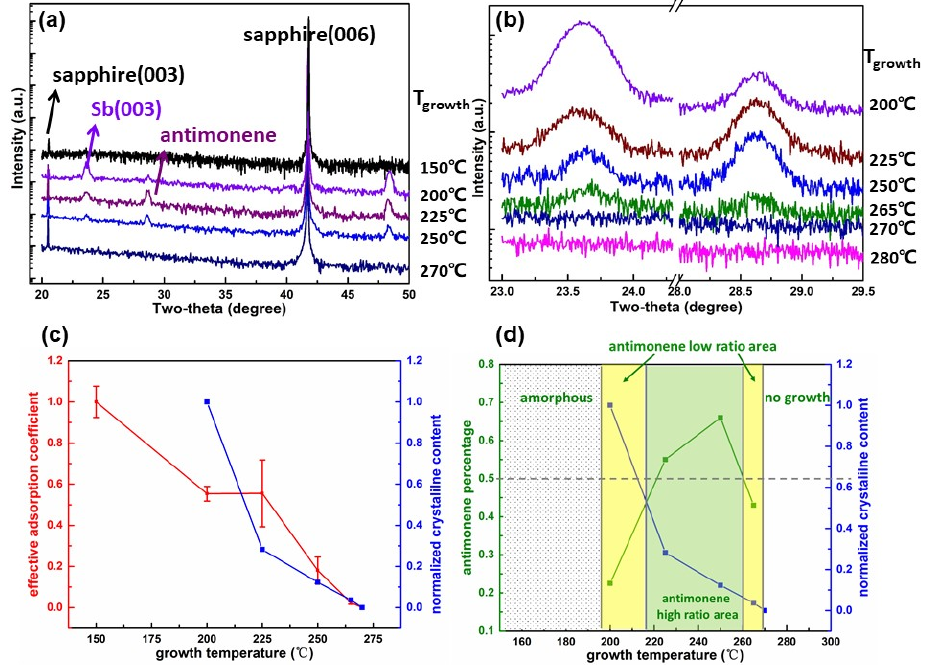
Figure 3. ( a ) XRD di ff ractograms of some group A samples using Sb 4 . ( b ) XRD di ff ractograms between 23 ◦ –29.5 ◦ , showing the antimonene features. ( c ) The e ff ective adsorption coe ffi cient of Sb 4 and normalized crystalline contents (integrated area of antimony (003) and (012) peaks. The maximum is 1 after normalized) as a function of the growth temperature. ( d ) Phase diagram showing the comparison of the antimonene formation and total crystalline contents as a function of growth temperature, indicating the competing mechanisms between the adsorption and nucleation of antimony